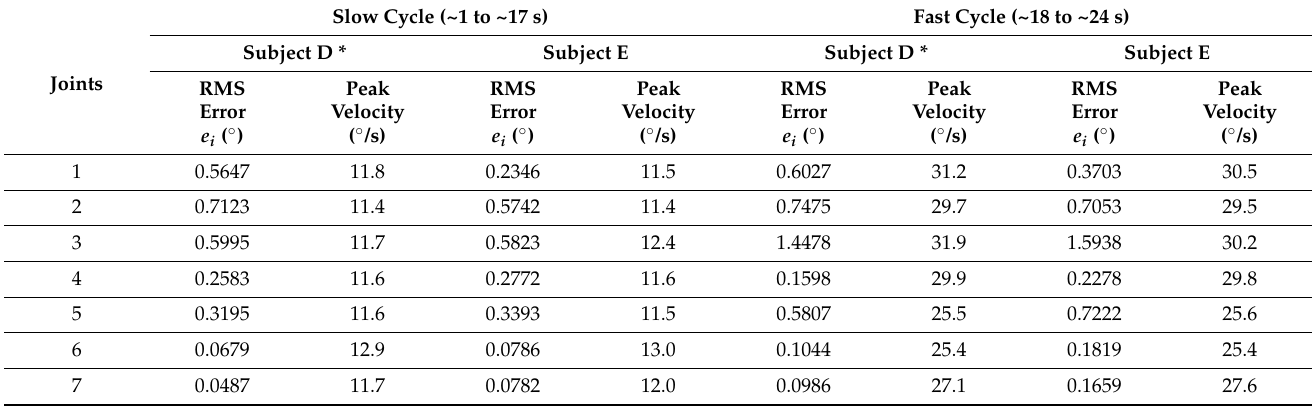
Table 9. Statistical analysis of tracking error and peak velocities, while Subjects D and E resist all seven joints’